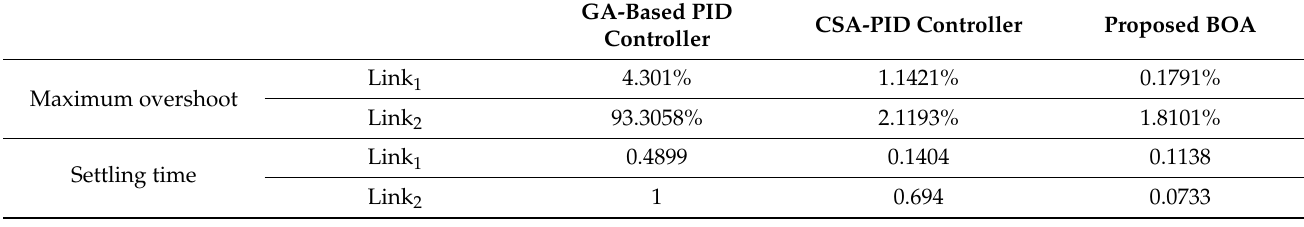
Table 4. The supreme overshoot as well as the settling time of the system responses for Scenario 1 due to each technique.